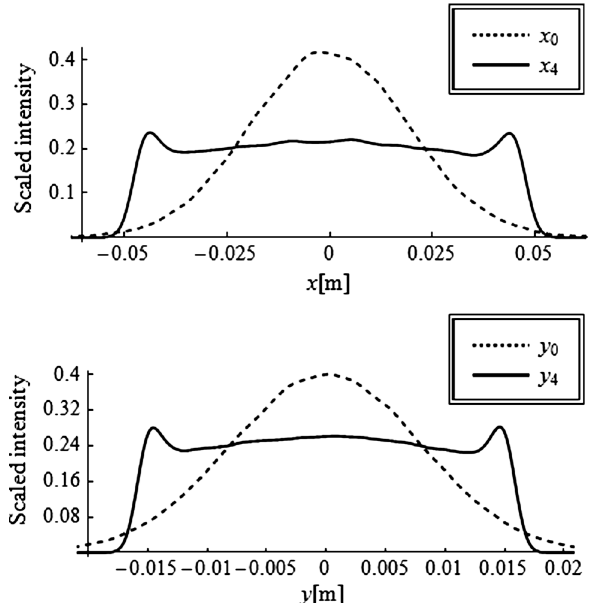
(cid:2) . The dashed curve stands for (the bottom plot) when ’ ¼ 1 180 the initial Gaussian distribution; the solid curve stands for the uniformed beam distribution.